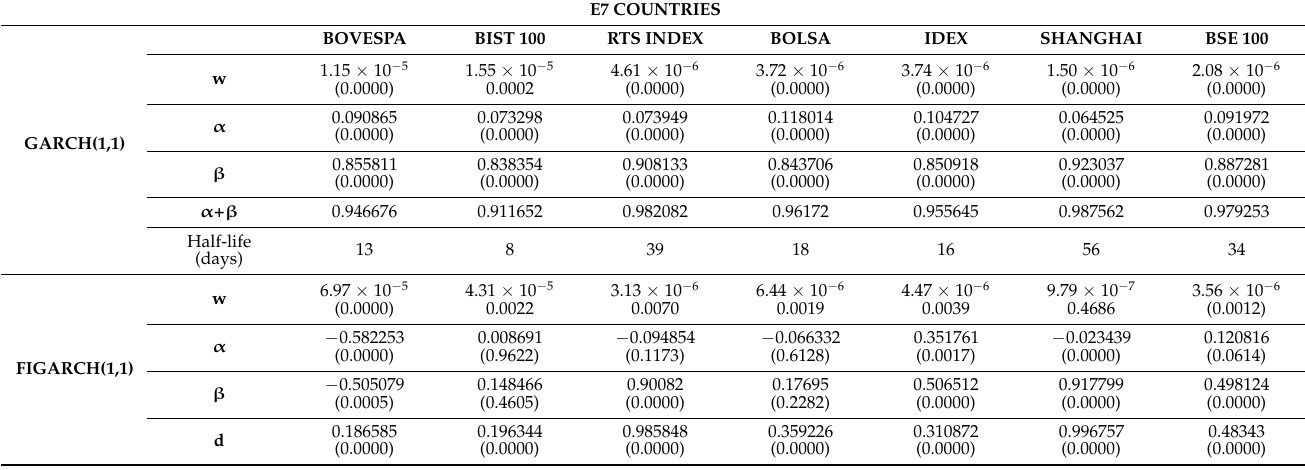
Table 10. E7 Volatility